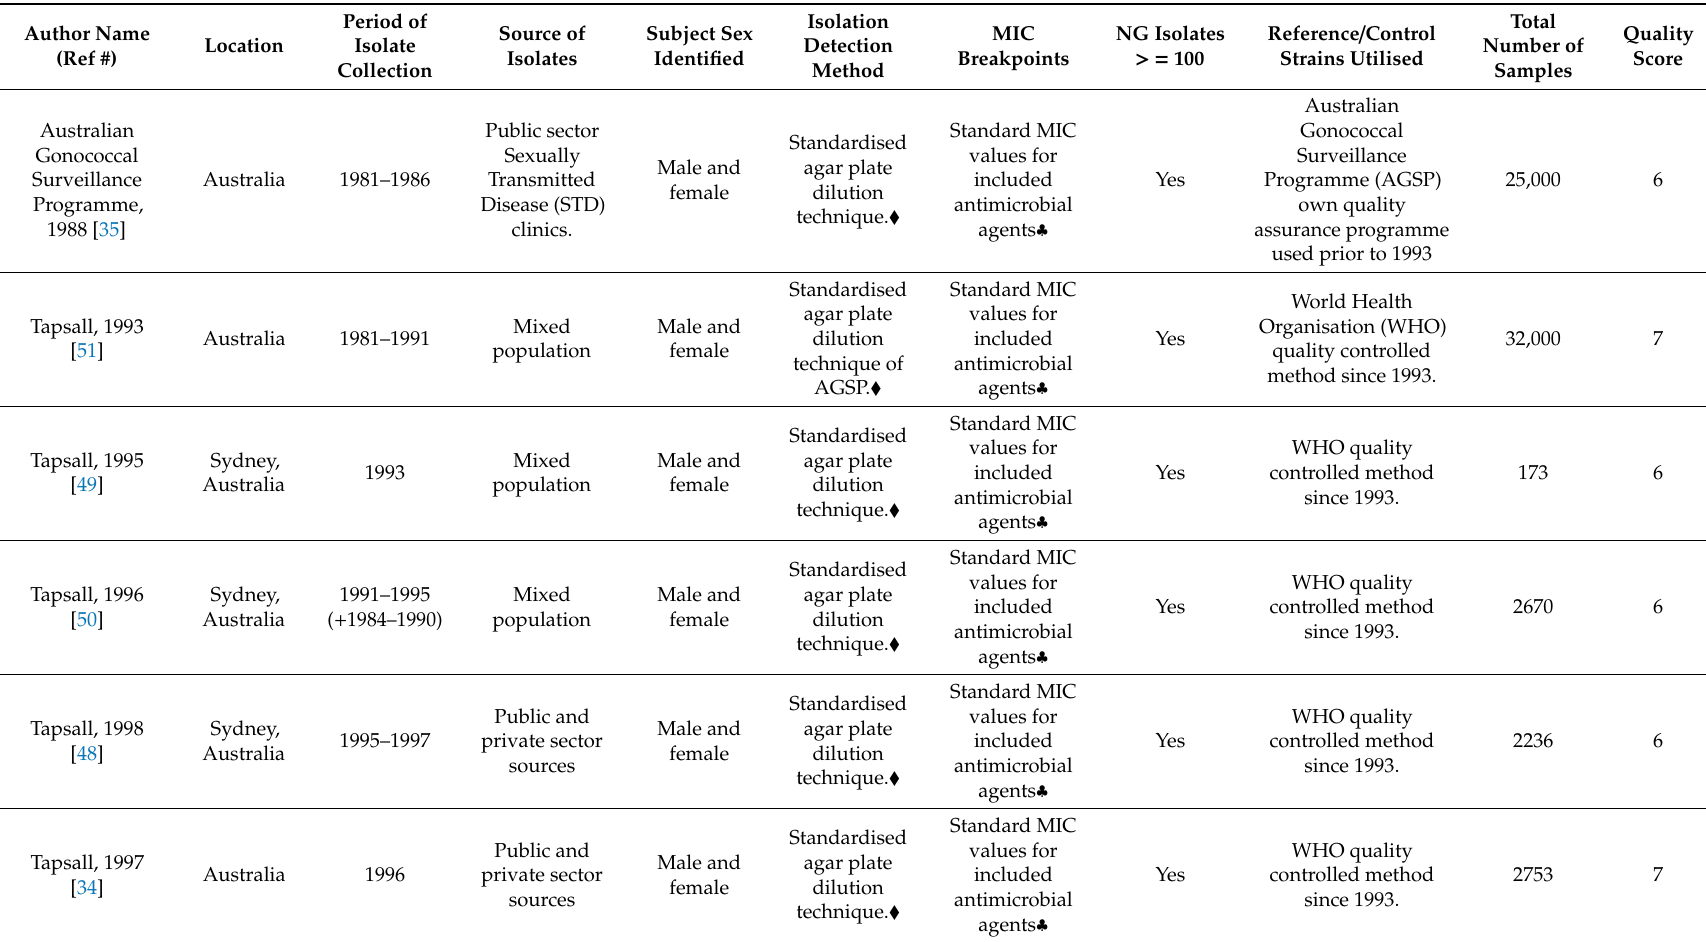
Table 1. Summary of the main characteristics of included studies and their respective quality assessment